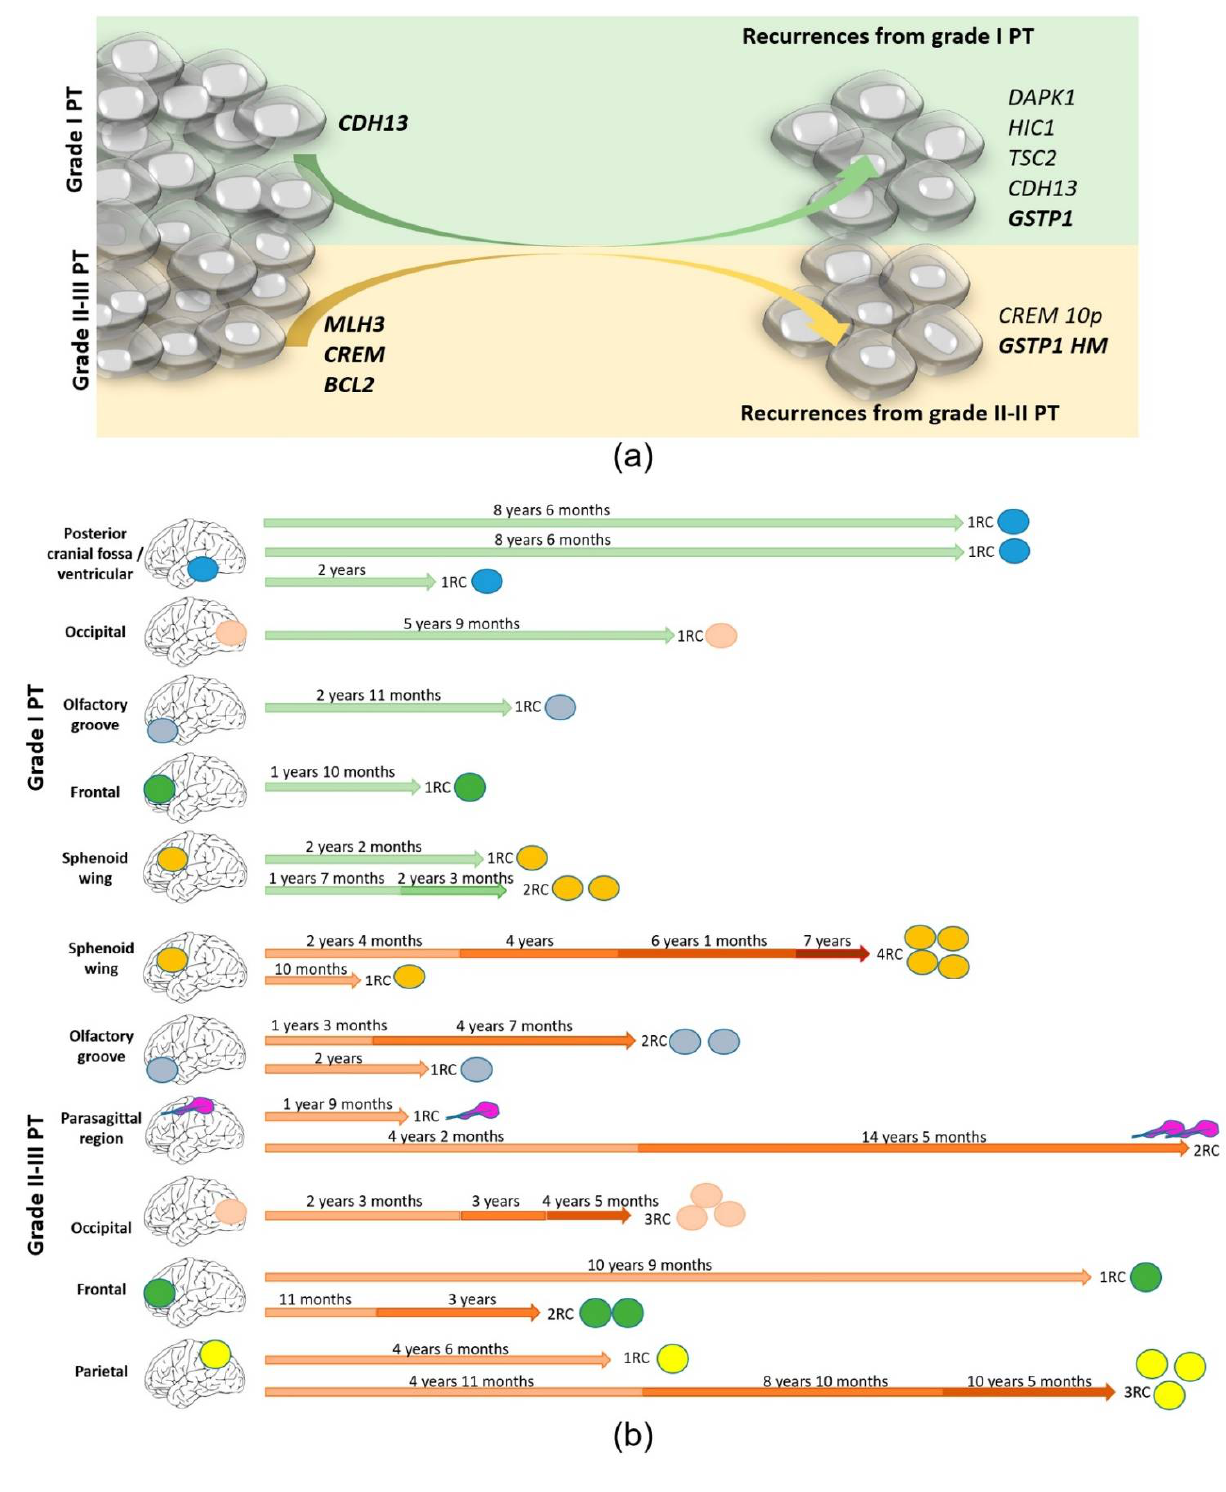
Figure 2. ( a ) The genetic and epigenetic changes in MN are different between grade 1 PTs and higher grades but frequent in both groups. Grade 2–3 PTs offer consistent alterations located in a few chromosomes (1, 14, and 18), while grade 1 PTs display randomly distributed alterations. RCs from primary grade 2 to 3 MN introduce a few changes because it is higher than its initial burden, while the progression of grade 1 MN, which displayed more random alterations initially, introduced many concrete changes when it recurs ( b ). Timing of the disease according to the grade of the PT (grade 1 in upper part/ grade 2–3 in lower part) indicating the location of the primary in each case.